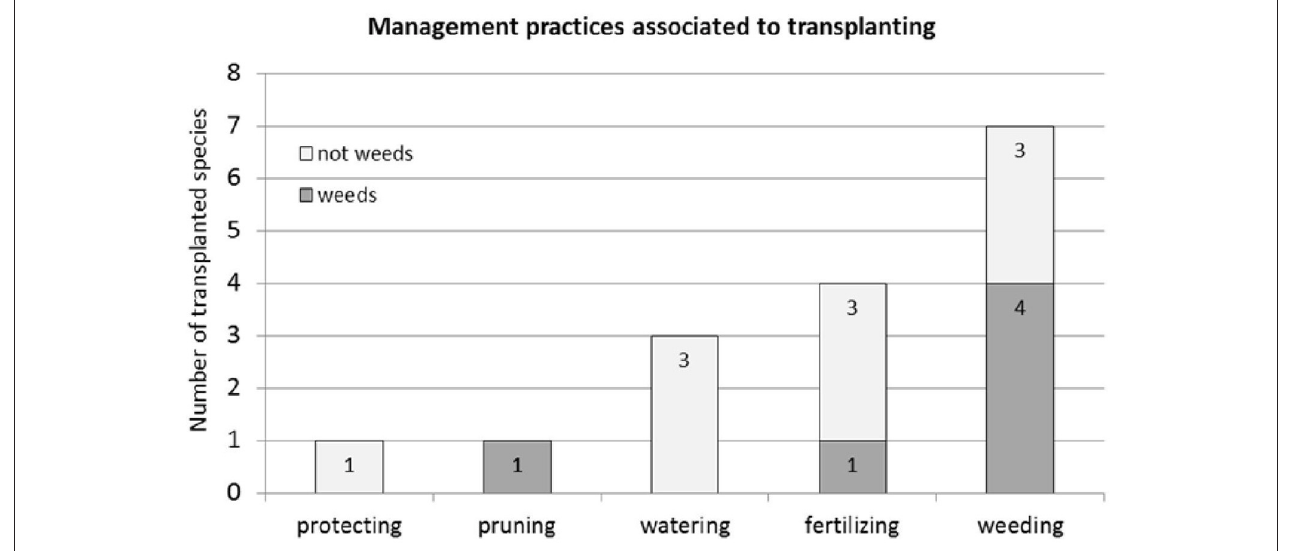
FIGURE 3 | Additional management practices associated with transplanting “wild” food plant species ( n =